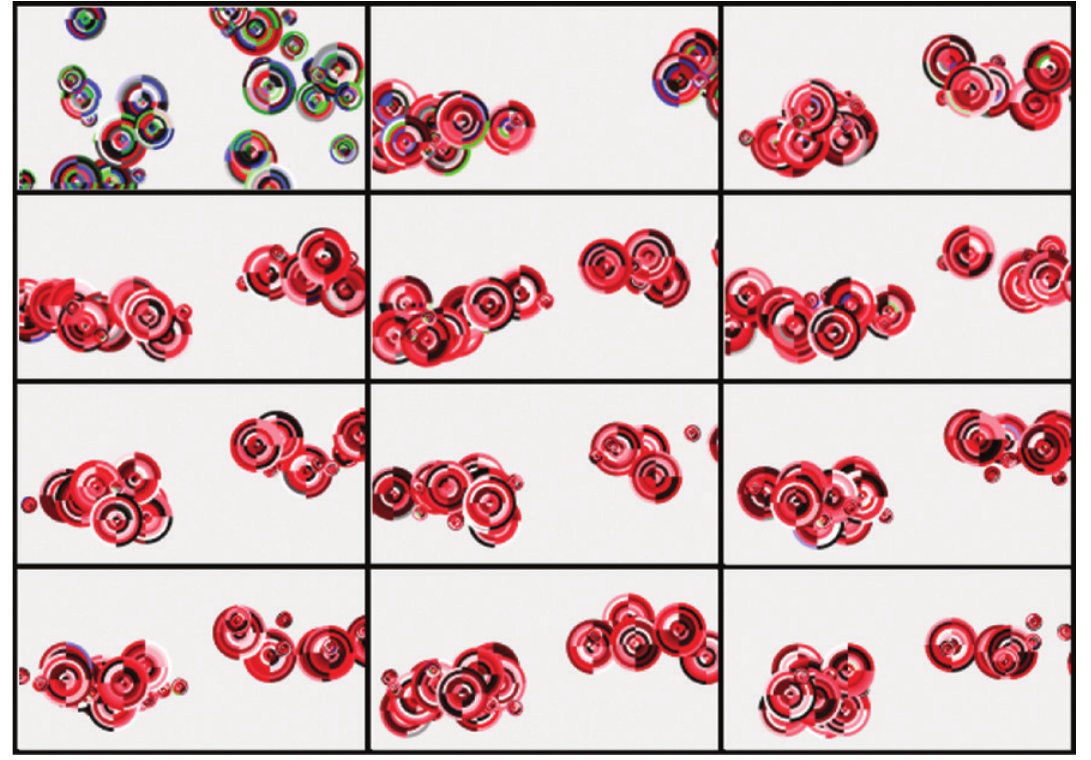
Figure 12: Progression of Evolution for Experiment 18.